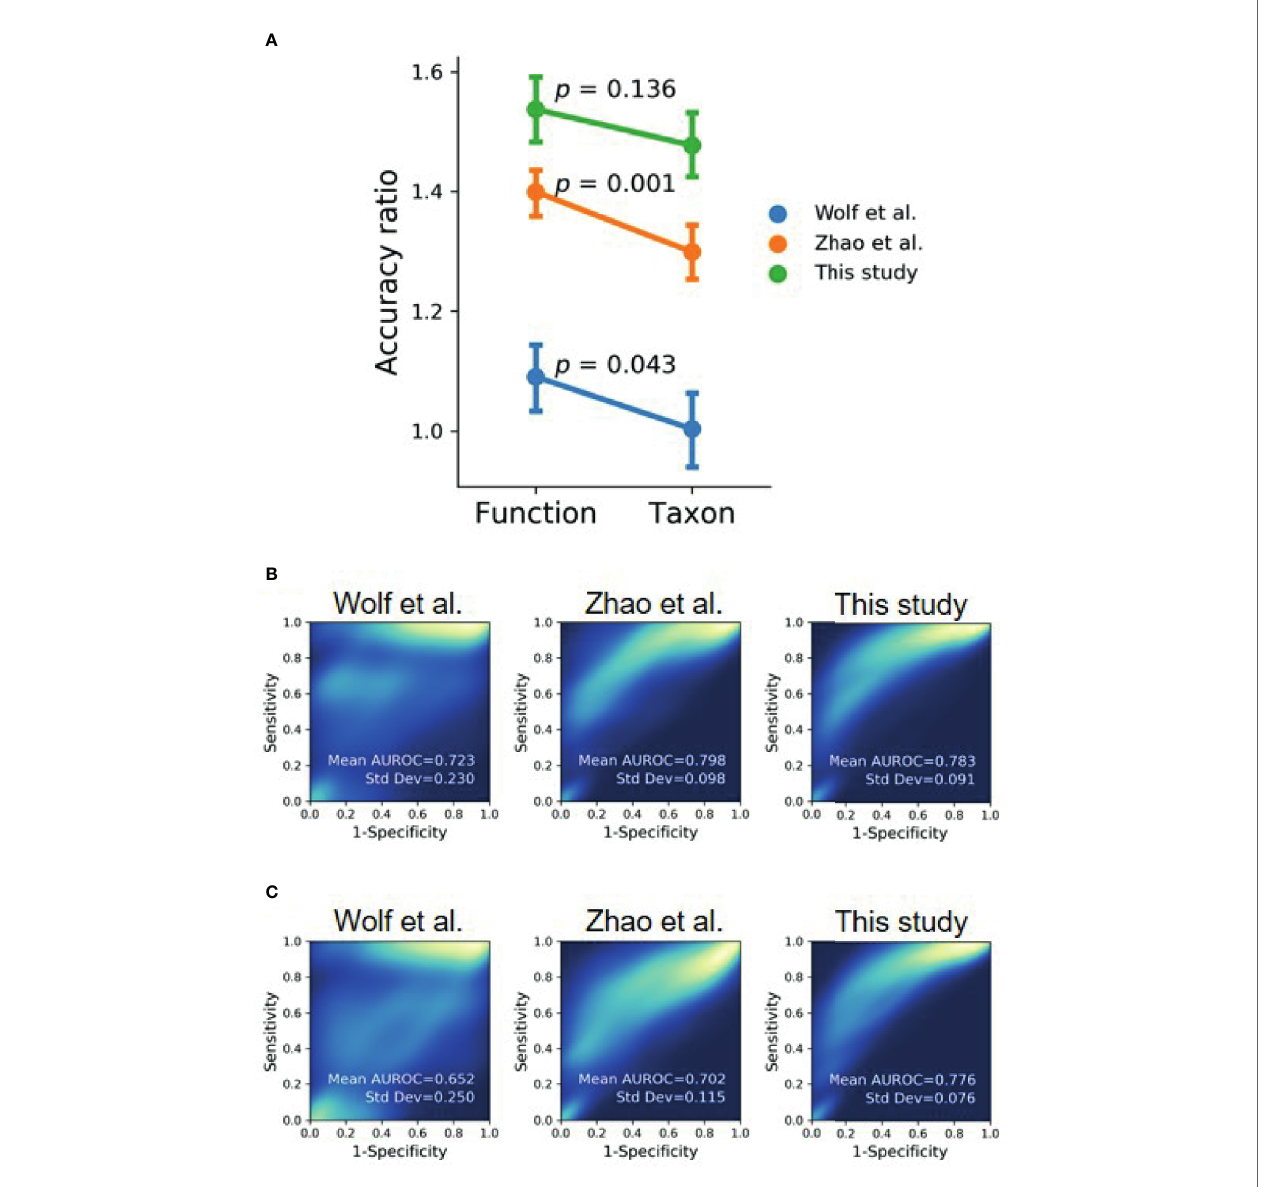
FIGURE 7 | Evaluating functional pro fi le as an alternative signature for OSCC detection using machine learning with the datasets of this study and previous studies (Wolf et al., 2017; Zhao et al., 2017). (A) The mean accuracy ratios of 100 iterations of the randomly split dataset (80% training and 20% testing) were based on taxonomic and functional pro fi les. The accuracy ratio is de fi ned as the predicted accuracy to the accuracy of a random guess. Vertical bars indicate 95% con fi dence intervals. (B, C) The 2D-density plots of ROC curves from 100 iterations demonstrate a higher mean AUROC using (B) functional pro fi les to distinguish OSCC from normal cohorts compared to that using (C) taxonomic pro fi